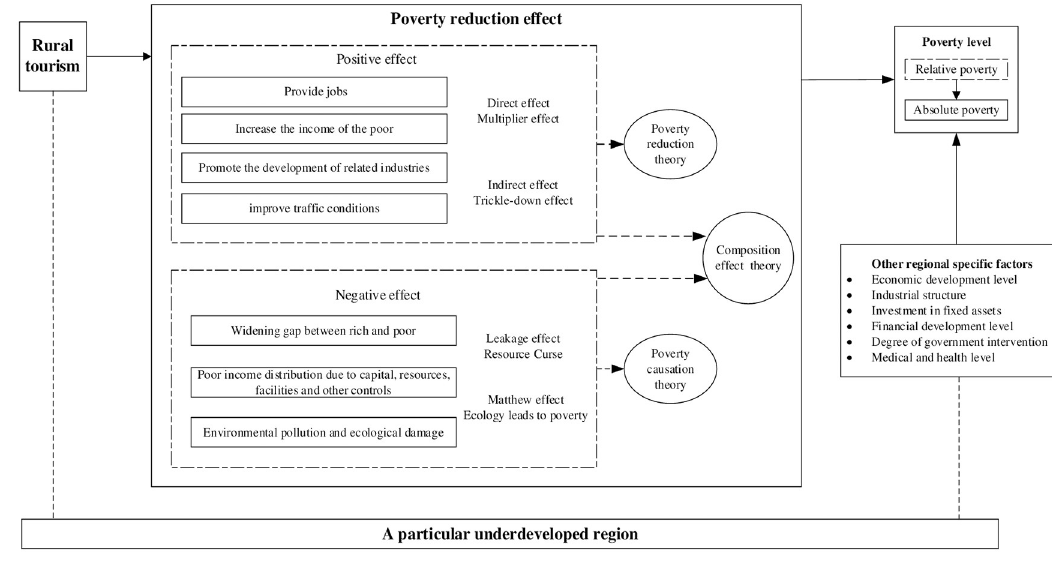
Fig 1. Theoretical analysis